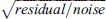
. Factors affecting linearity.A-E: Mitral input-output curves simulated in a default network (Figs 2D and 4D(i)) and modifications thereof. In each case mitral firing rate is plotted against ORN firing rate to the tuft of mitral cell A. Activity-dependent lateral inhibition to A, mediated by granule cells, is assessed in each case by considering a lateral ‘super-inhibiting’ mitral cell B receiving Poisson ORN input at 0 Hz (black squares), 5 Hz (red diamonds) and 10 Hz (blue circles). A. default. B. PG cells removed. C. granule cells removed. D, E: The default network is modified to have stronger PG cell excitation yielding half-Mexican-hat profiles i.e. suppression of mitral firing for low ORN input. D. ORN→PG and mitral→PG synaptic strengths are increased by 2.4 times for both plateau-ing and low threshold spiking PG cells. E. ORN→PG and mitral→PG synaptic strengths are increased by 6 times for plateau-ing PG cells but unchanged for low threshold spiking PG cells. F-J. The histograms of residual/noise for fits to single odor random pulse-trains (top row) and for predictions to two-odor random pulse-trains (bottom row) corresponding to above A-E cases respectively, from 30 network instances, each with different two odors. All values for residual/noise>2 are in the right-most bin. The mitral input-output curve saturated to a small extent on removing granule cells (C) causing a worsening of the linear fits and predictions. But on removing PG cells (B), the saturation was much stronger and the lateral inhibition for 10 Hz input to lateral mitral cell B was less than that for 5 Hz. On modifying the input-output curve to have an initial supra-linear region (half-Mexican-hat) (D,E), the predictions were often seen to be supra-linear compared to the fits. Also, the lateral inhibition turned on with a threshold, i.e. negligible for 5 Hz input to mitral cell B but large for 10 Hz, since the lateral mitral cell B had the same non-linear input-output curve.